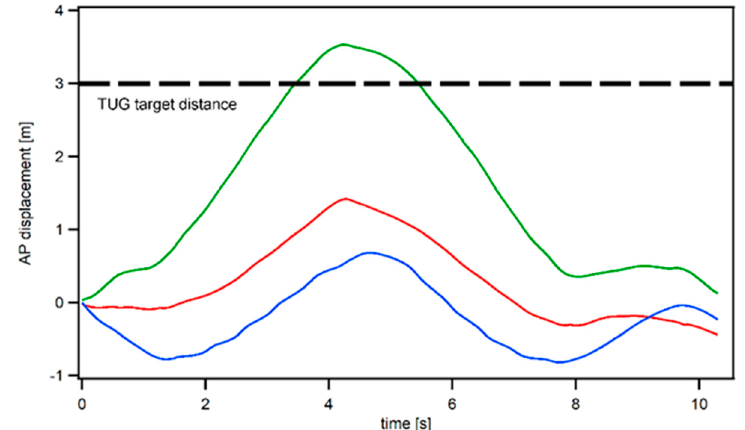
Figure 4. The sample AP displacement in the TUG task. Red denotes the HD sensor, and blue denotes the LB sensor. Note that only the HoloLens AP displacement measure correctly matches the 3 m walking path utilized in the TUG task.